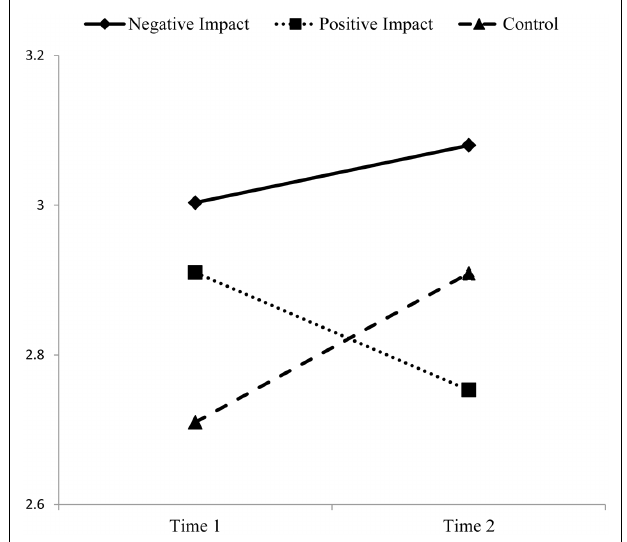
FIGURE 2 |Work-life conflict pre- and